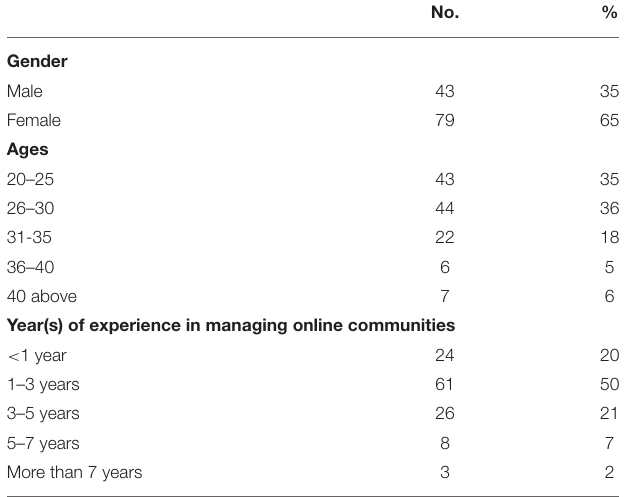
TABLE 1 | Profile of the respondents ( N =